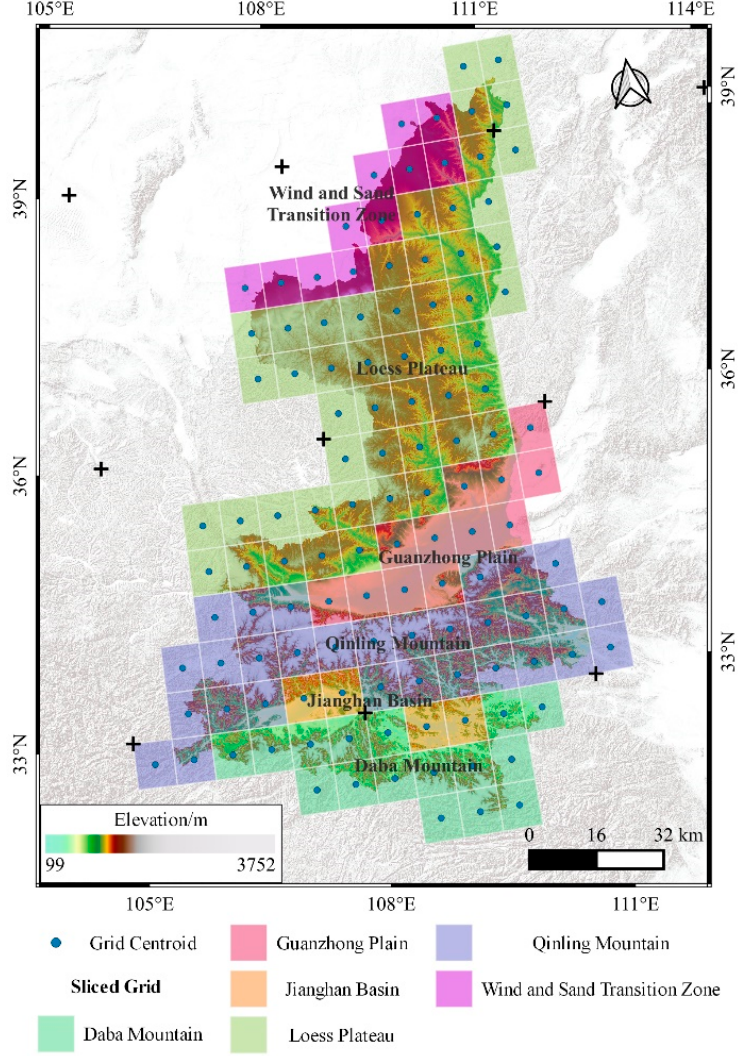
Figure 12. Spatial distribution of grid cells in Shaanxi Province: the blue dot represents the centroid of each gird; colored rectangles indicate the spatial extent of these cells, and different colors are adopted for different geomorphological regions.